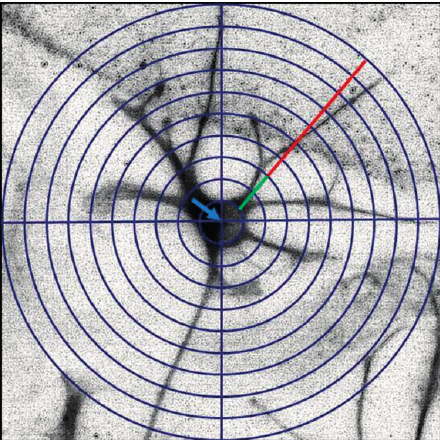
Figure 8. Schematic drawing of the modified Sholl method to determine the number and length of primary and secondary dendrites. A grid of concentric circles equidistantly drawn five micrometers apart was superimposed at the center of the neuronal soma (blue arrow). Dendrite formation was determined by counting the number of emerging dendrites from the soma. Primary dendrite length was measured from the soma up to the first intersection (green line). Complexity of dendrites was determined by counting the number of secondary dendrites as well as by measuring their length (red